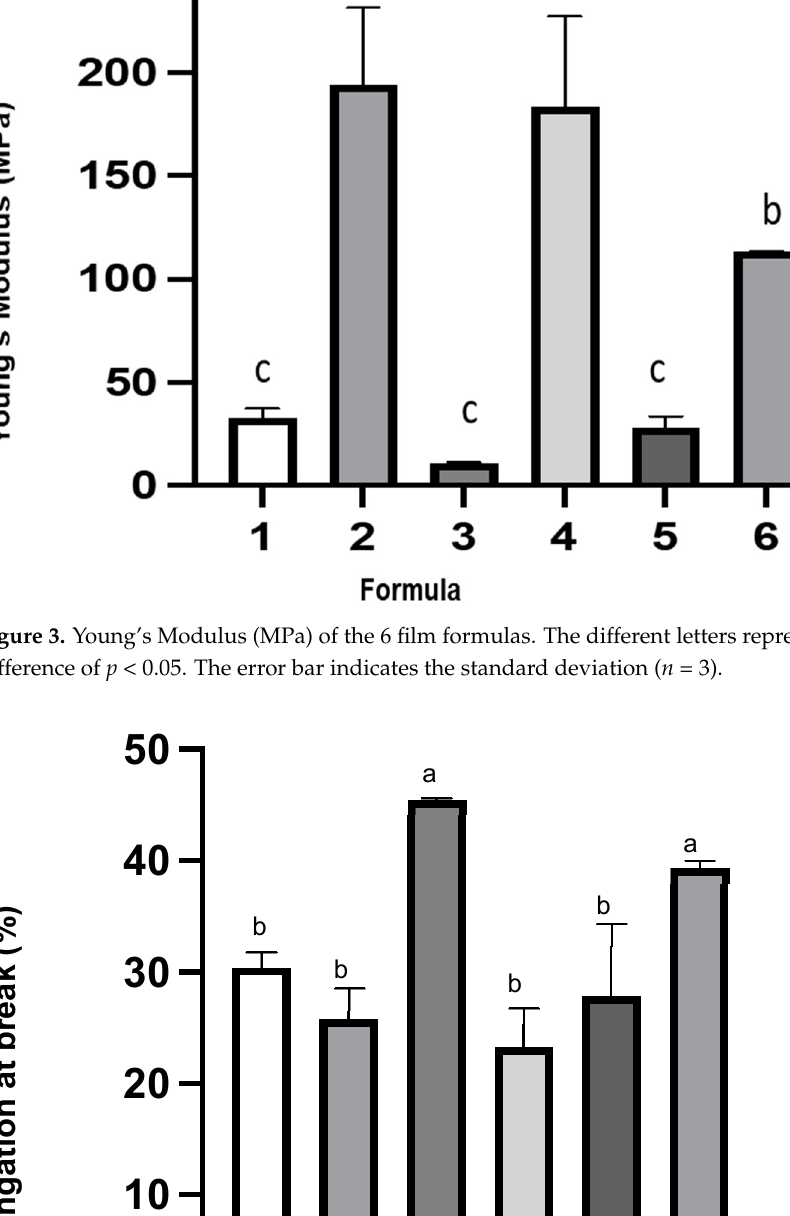
Figure 2. Tensile strength (MPa) of the 6 film formulas. The different letters represent a significant difference of p < 0.05. The error bar indicates the standard deviation (n = 3).